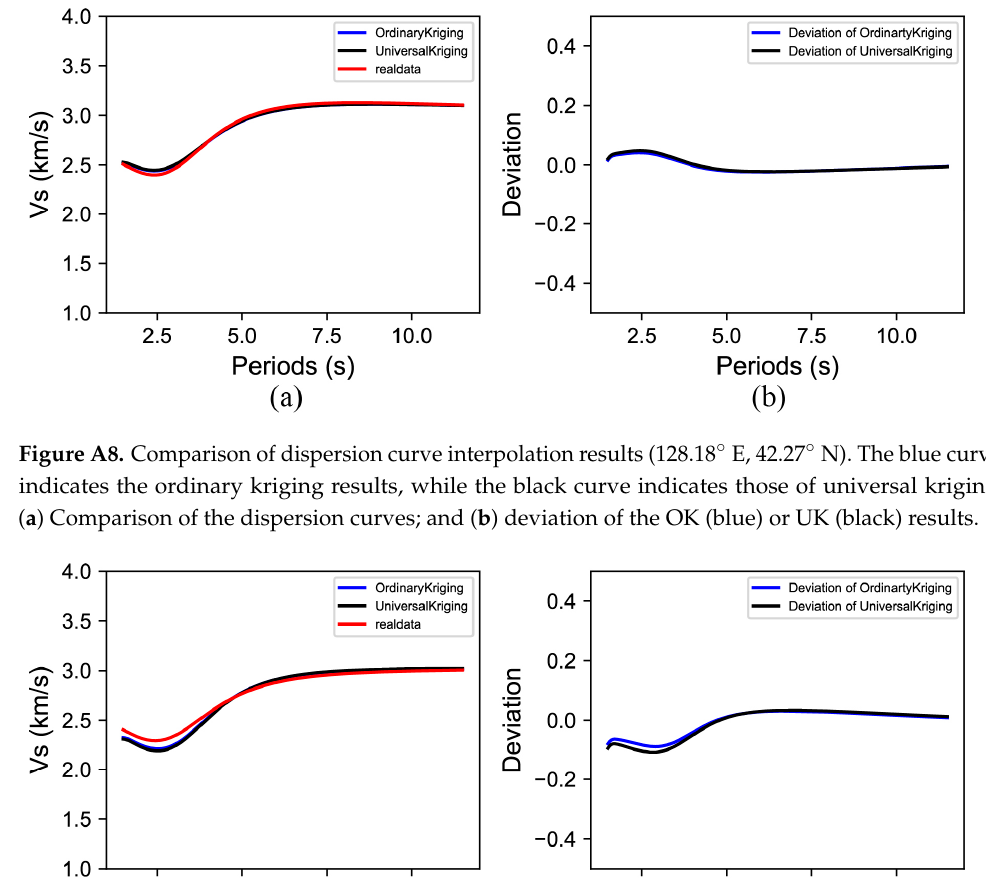
Figure A7. Comparison of dispersion curve interpolation results (128.18° E, 42.18° N ). The blue curve indicates the ordinary kriging results, while the black curve indicates those of universal kriging: ( a ) Comparison of the dispersion curves; and ( b ) deviation of the OK (blue) or UK (black) results.